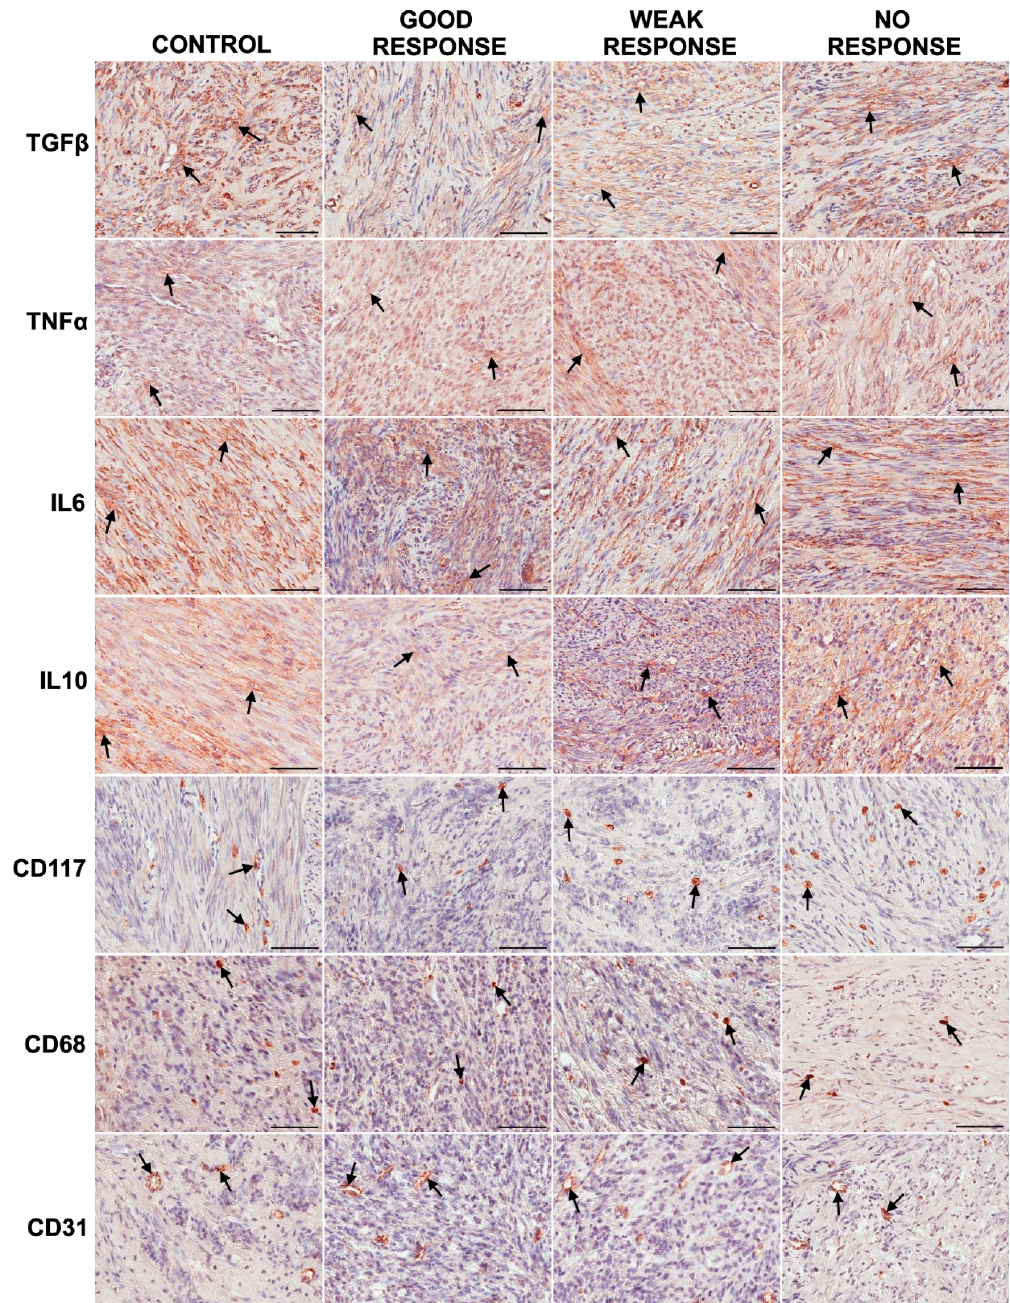
Figure 1. Representative light micrographs of immunoexpression (brown-stained cell cytoplasm indicated by black arrows) of inflammatory markers and vessel marker in fibroid cells in the control group and study groups after 3 months of treatment with ulipristal acetate (UPA): good, weak, and no response to treatment. Note: scale bar—100 µ m. Abbreviations: CD31—marker of endothelial cells; CD68—marker of cells of the macrophage lineage; CD117—marker of mast cells; IL6—interleukin 6; IL10—interleukin 10; TGF β 1—transforming growth factor β 1; and TNF α —tumor necrosis factor α